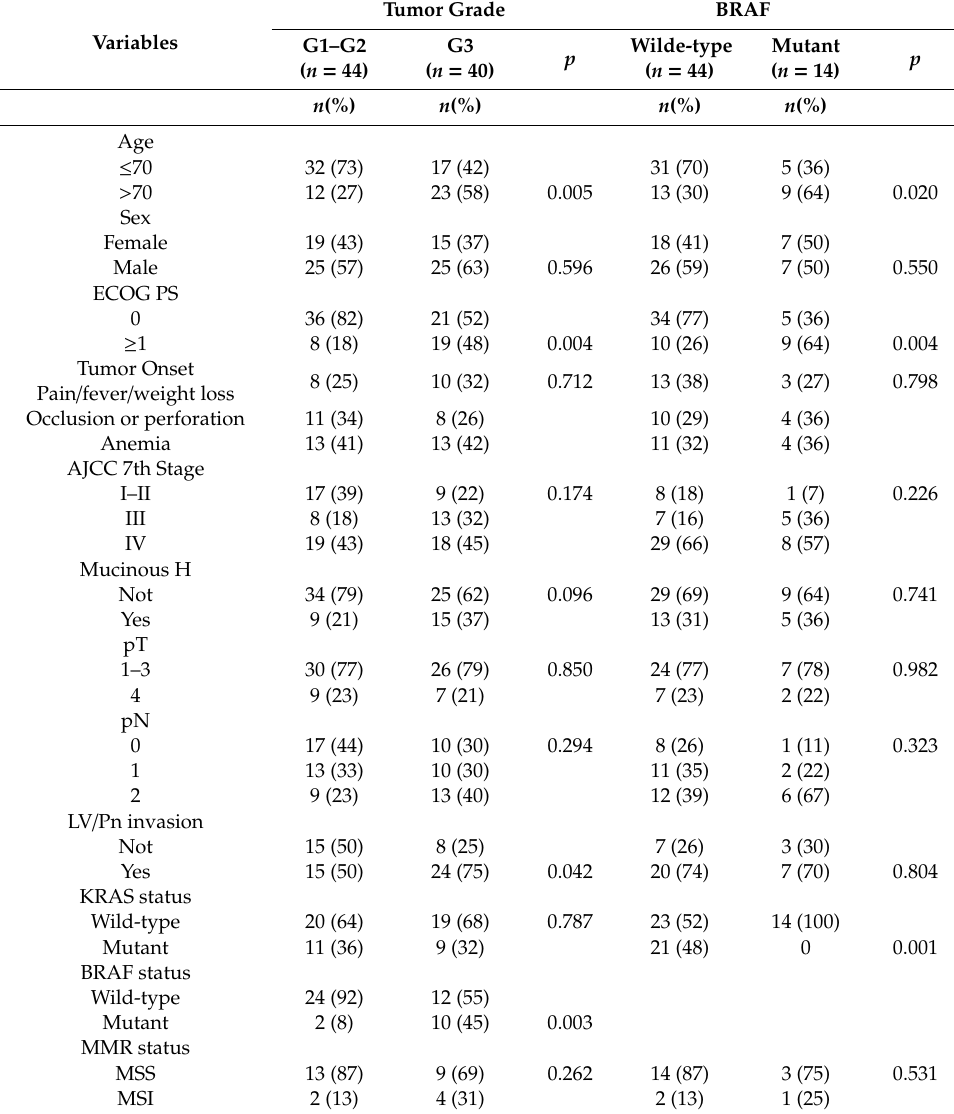
Table 3. Correlation between tumor grade and BRAF status with clinic-pathological